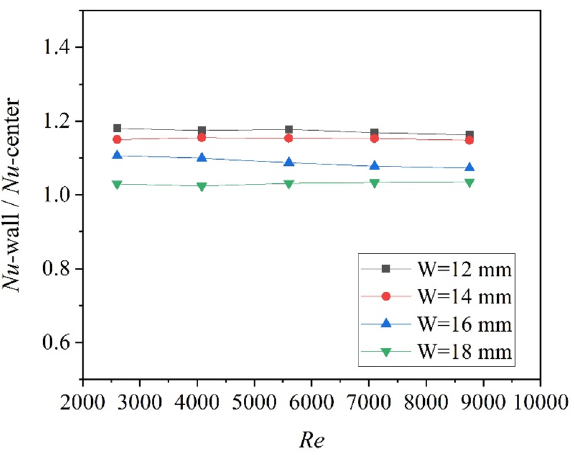
Figure 9. Variation of Nusselt number ratio (Nu-wall/Nu-center) with Re.